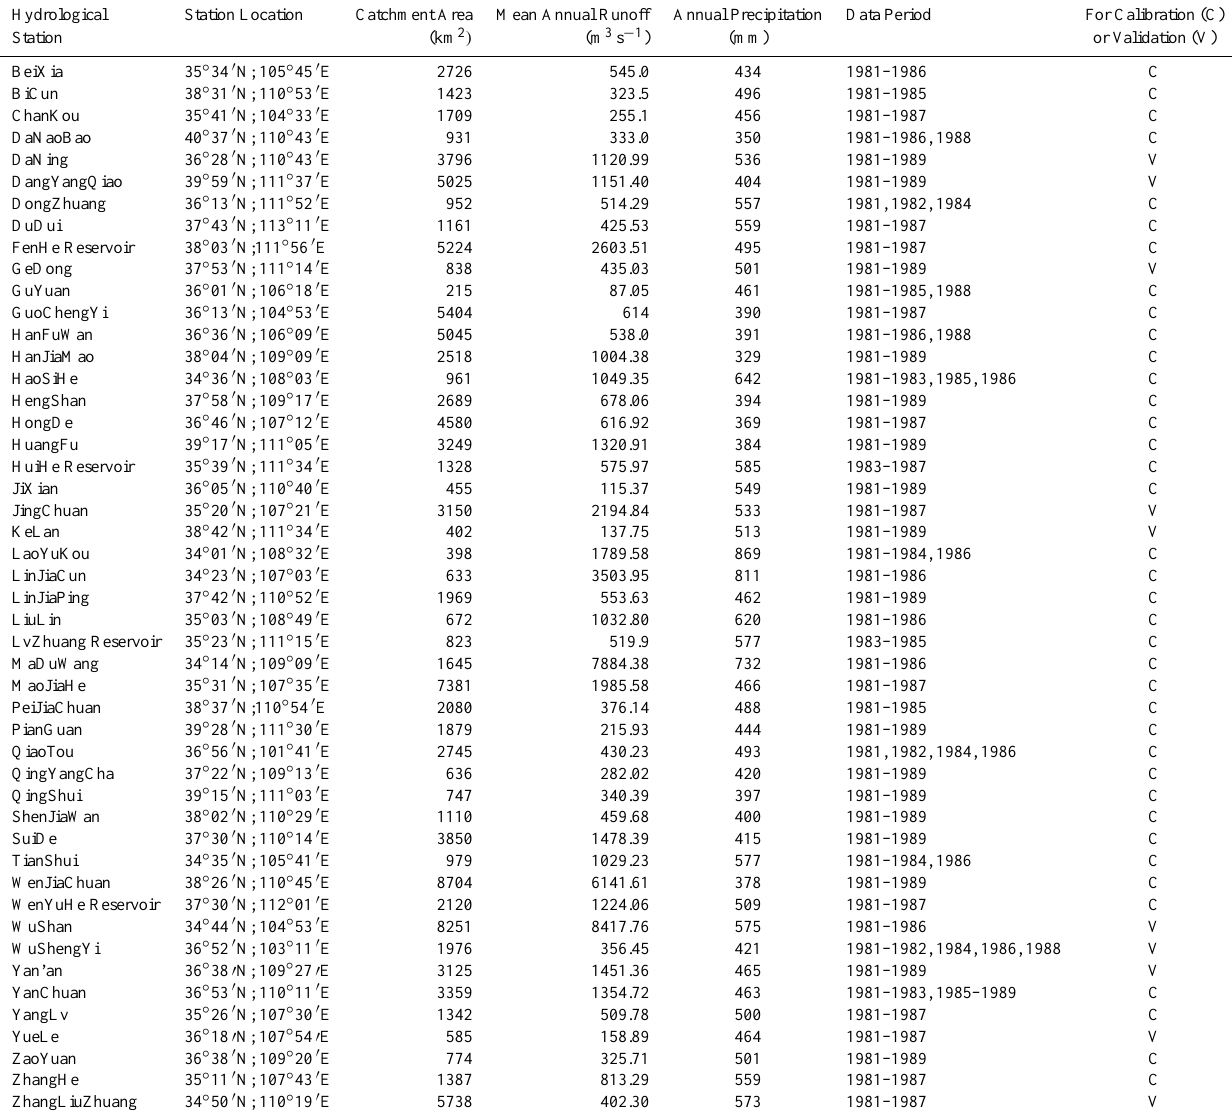
Table 1. Hydrometeorolgical characteristics of catchments for model calibration and validation. Hydrological